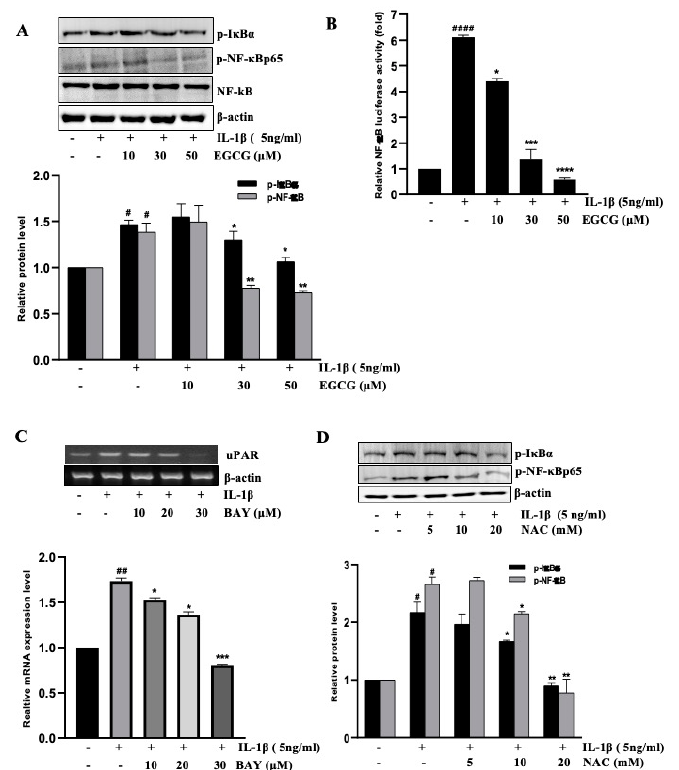
Figure 5. EGCG Suppresses IL-1 β -induced NF- κ B signaling in T24 cells. ( A ) T24 cells were pre- treated with 10–50 µ M EGCG and incubated with 5 ng/mL IL-1 β for 4 h; cells were then harvested to check for p65 and I κ B α by Western blot analysis. ( B ) Cells were pretreated with EGCG (10, 30, and 50 µ M), were transiently transfected with the AP-1 luciferase reporter plasmid and were incubated with 5 ng/mL IL-1 β ; the cells were lysed, and luciferase activity was determined. ( C ) T24 cells were pretreated with 10–20 µ M Bay and incubated with 5 ng/mL IL-1 β for 4 h. The cells were then extracted for mRNA, and uPAR expression was checked by RT-PCR. ( D ) T24 cells were pretreated with 5–20 mM NAC for 1 h and incubated with 5 ng/mL IL-1 β for 4 h, cells were then harvested to check for p-NF- κ B and p-I κ B α by Western blot analysis. The above data represent the mean ± SD from triplicate measurements ( # p < 0.05, ## p < 0.01, #### p < 0.0001 versus control; * p < 0.05, ** p < 0.01, *** p < 0.001, **** p < 0.0001 versus IL-1 β